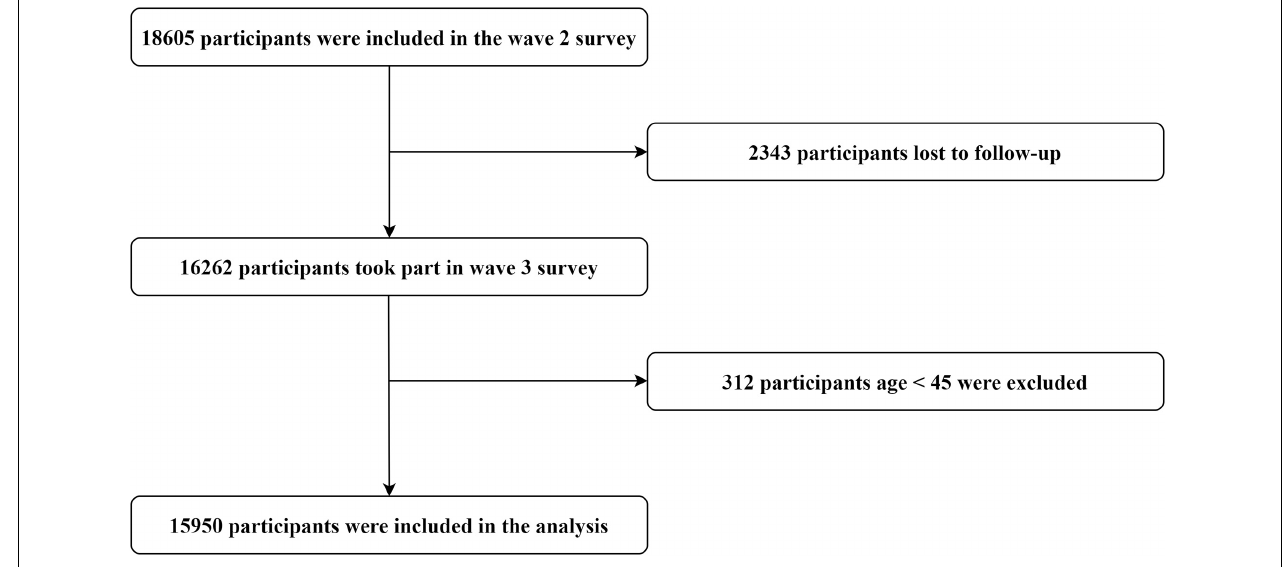
FIGURE 2 | Flowchart of the inclusion and exclusion of